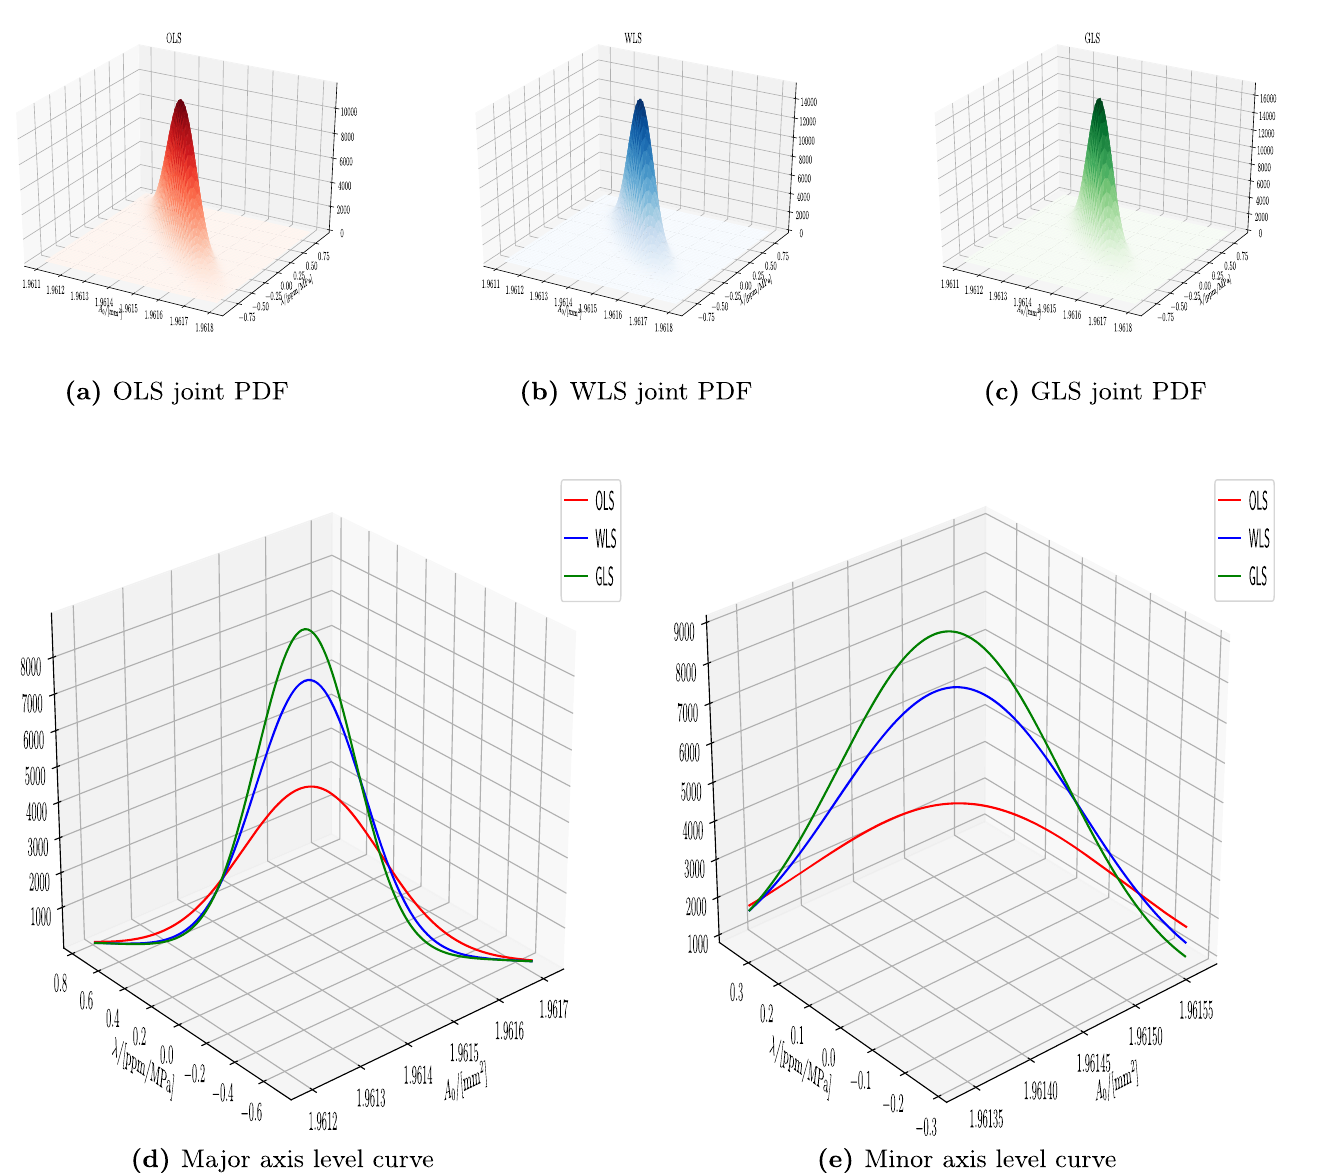
Fig. 4. Comparison of joint PDFs from OLS, WLS and GLS regressions. The con fi dence region may be visualized as a three dimensional volume underneath the envelope covered by the joint PDF and bounded by the hyper-ellipsoids, and indicates that the joint PDFs may fi t inside one another. Due to the dif fi culties with visualizing three different joint PDFs intersecting within each other simultaneously, cuts along the major axis (orange line in previous fi gure) and minor axis (magenta line in previous fi gure) of the ellipsoids con fi dence regions are taken which produce level curves to more easily visualize the shape, orientation and size of the different OLS, WLS and GLS regression schemes. From these level curves it is observed that for level curves along the ellipsoid major axis that the GLS regression (green curve) has the narrowest/sharpest curve which corresponds to the highest con fi dence or accuracy in the estimates of the parameters, then the WLS regression (blue curve) which has a medium spread/sharpness, and fi nally the OLS regression (red curve) which is relative wide and fl at which corresponds to less certainty/accuracy of the parameters in the regression analysis. A broadly similar behaviour is observed for level curves cut along the minor ellipsoid axis, and as a result it is observed and concluded a OLS regression has the least accuracy, a WLS regression has a medium accuracy, and a GLS regression has the highest accuracy. From the above graphs it may be concluded that a straight line regression for pressure metrology work should ideally utilize a GLS regression (green line) however if no covariance information is available the a WLS regression (blue line) can give a reasonable estimate particularly for industrial pressure metrology